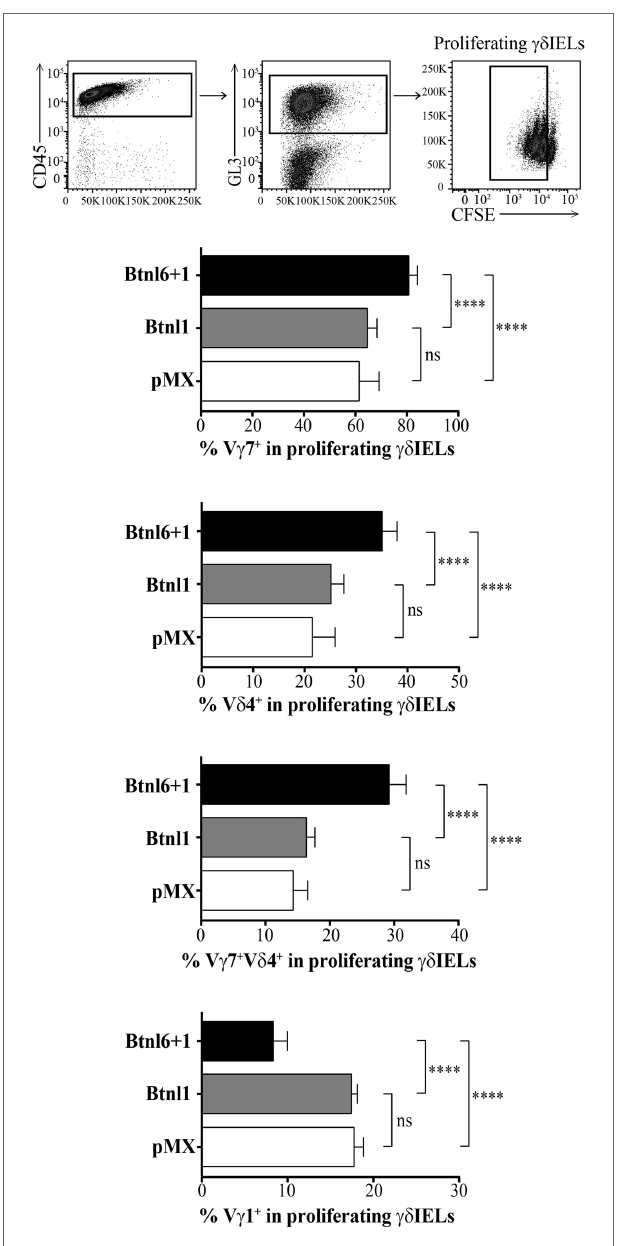
FigUre 7 | The Btnl1–Btnl6 complex specifically induces the proliferation of iels bearing the V γ 7V δ 4 receptor. Murine MODE-K cells transfected with Btnl6 and Btnl1 cDNA pMX-IRES-GFP, Btnl1 cDNA pMX-IRES-GFP, or empty vector (pMX-IRES-GFP) were cocultured with CFSE-labeled IELs in the absence of anti-CD3 activation in the presence of IL-2. The proliferating population among the γδ TCR IELs in the various coculture conditions was analyzed for the expression of V γ 7, V γ 1, and V δ 4 chains. Bars show the mean ± SD, and data are pooled from four independent experiments in duplicates. * P ≤ 0.05, ** P ≤ 0.01, *** P ≤ 0.001, and **** P ≤ 0.0001 as determined by unpaired two-tailed t